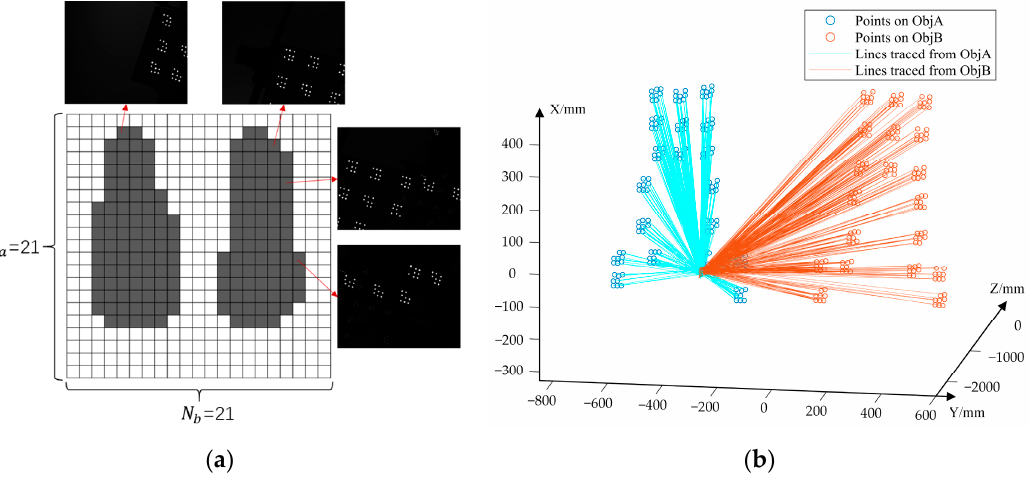
Figure 19. Pose estimation using the VMOS. ( a ) The virtual cameras participating in the pose estimation and the photos taken by the virtual cameras. ( b ) The lines and object point correspondences.